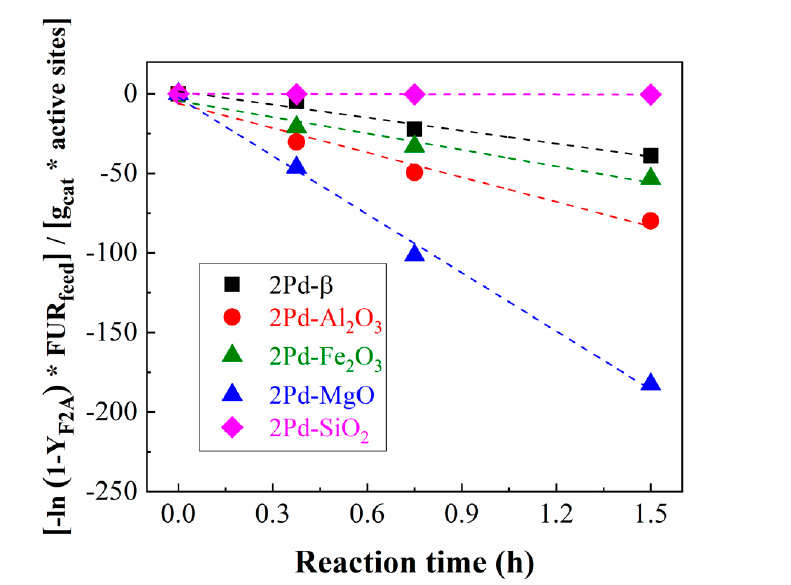
Figure 8. Kinetic study in the formation of F2A with Pd-based catalysts. Experimental conditions: temperature: 170 °C, catalyst loading: 0.05 g, V (ethanol) :6 mL, amount of base (Na 2 CO 3 ): 0.10 g, V (H 2 O 2 , 30 wt%): 0.5 mL.